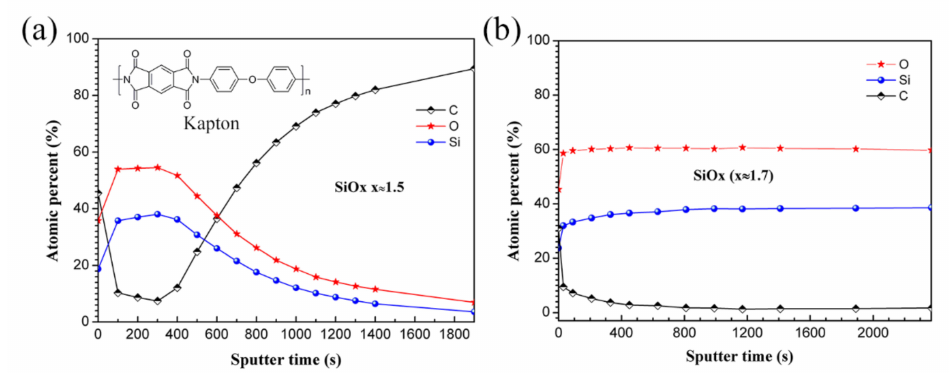
Figure 7. Depth profiles of C, O, Si elements in the ( a ) as-prepared and ( b ) AO-exposed PHPS coating (Total fluence of AO exposure: 1.5 × 10 21 atoms cm − 2